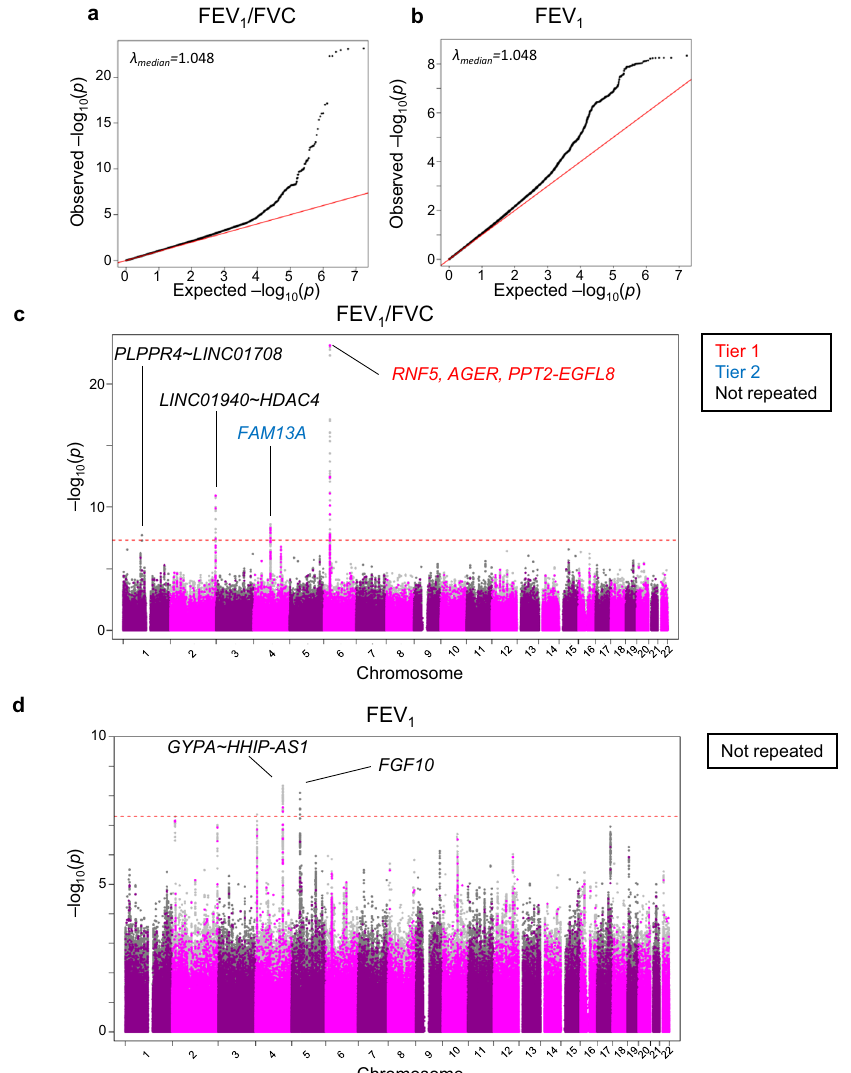
Fig. 2 GWAS for association with the measures of lung function at the Discovery Stage. GWAS was conducted for the association with the measures of lung function at the Discovery Stage. Quantile-quantile (QQ) plots of the observed versus expected log10( P ) values in FEV 1 /FVC ratio ( a ) and FEV 1 ( b ) are shown with the in fl ation factor ( λ ). The Manhattan plots of GWAS for the association with the FEV 1 /FVC ratio ( c ) and FEV 1 ( d ) show the chromosomal positions of variants exceeding the genome-wide signi fi cance threshold ( P < 5 × 10 − 8 as indicated by the dotted red line). Gene names in red correspond to tier 1 loci ( P < 5 × 10 − 8 both in the Discovery Stage and Validation Stage); gene names in blue correspond to tier 2 loci ( P < 5 × 10 − 8 in the Discovery Stage and P < 5 × 10 − 5 in the Validation Stage with consistent directions of effect); gene names in black correspond to genetic loci that had P < 5 × 10 − 8 in Discovery Stage but not repeated in the Validation Stage. Coloured circles mean the variants that were directly analysed. Grey circles mean the variants that were detected by genotype imputation. GWAS genome-wide association study, FEV 1 forced expiratory volume in one second, FVC forced vital